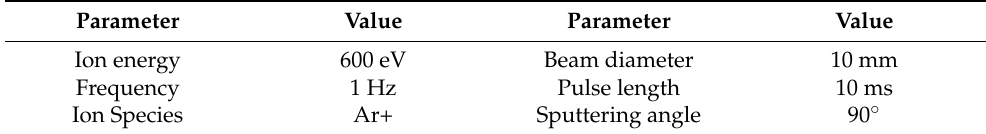
Table 1. PIB processing